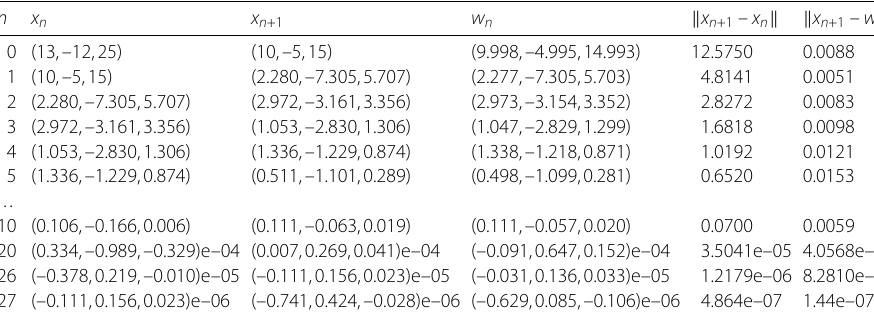
Table 1 Convergence of the sequence in Algorithm 3.1